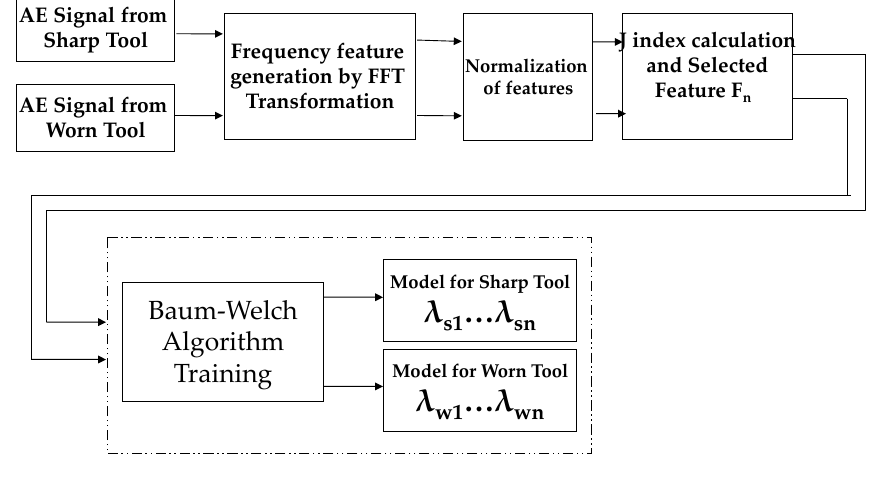
Figure 1. Schematic of tool condition monitoring.